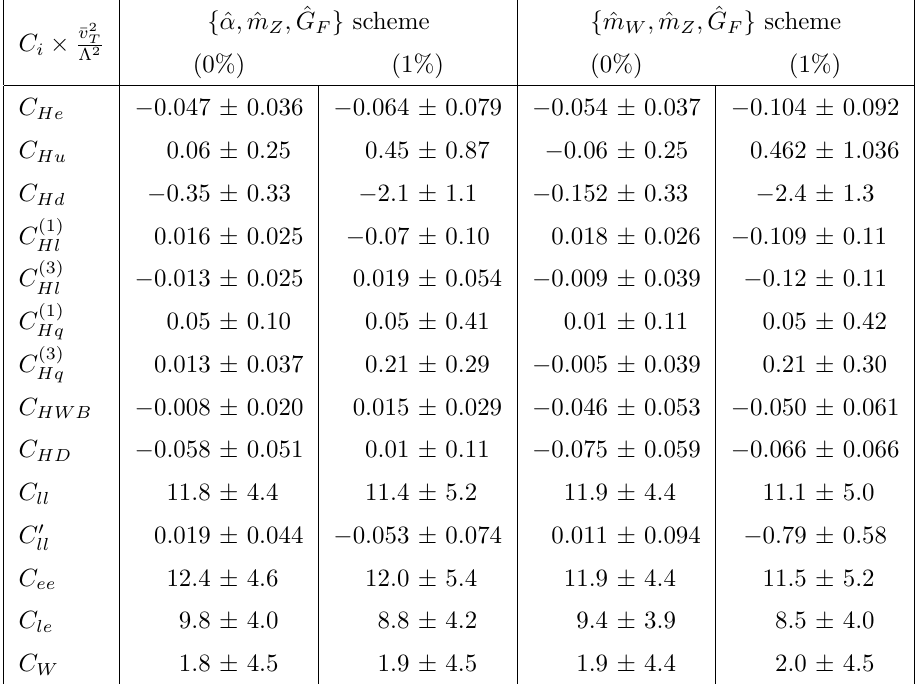
Table 6 . Best (cid:12)t values and corresponding 1 (cid:27) con(cid:12)dence regions for (cid:1) SMEFT = the two input parameter schemes considered in this work. These numbers have been obtained mini- mizing the (cid:31) 2 with one parameter at a time (despite the non-minimal character of the SMEFT [1]), and they have been multiplied by a factor